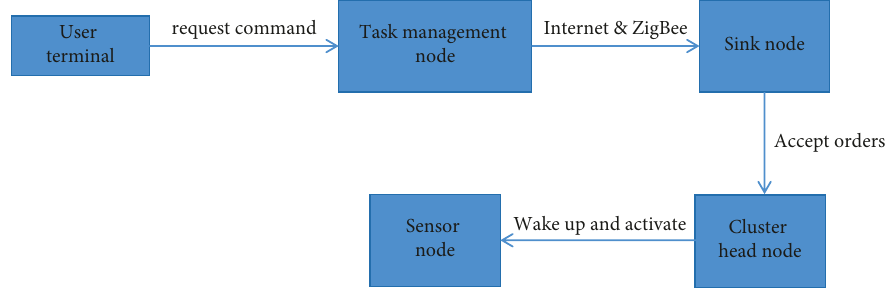
Figure 2: Workflow of the environmental information collection method for coumarin extraction.